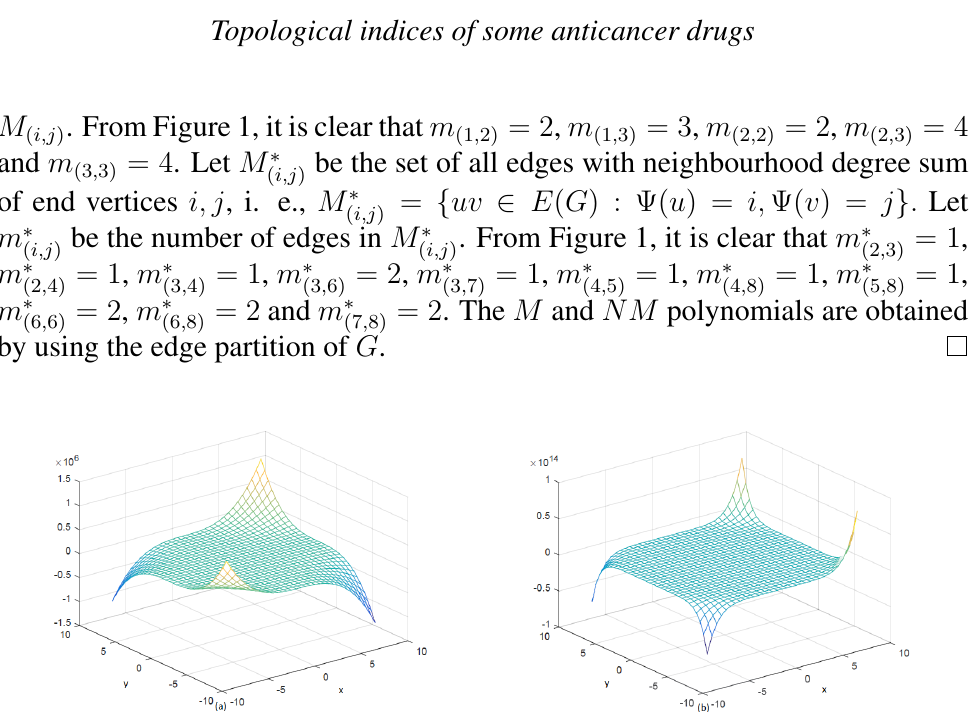
Figure 8: Plotting of (a) M-polynomial and (b) NM-polynomial of convolutamine